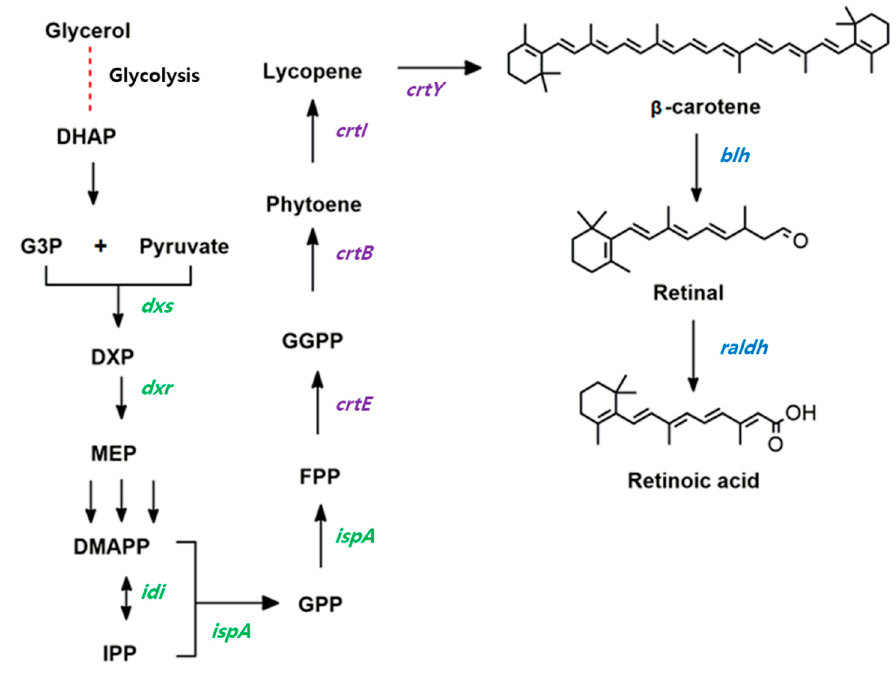
Figure 1. Redesigned biosynthetic pathway of retinoic acid from β -carotene in recombinant Escherichia coli . The genes involved in this redesigned pathway are dxs (encoding1-deoxy- D -xylulose- 5-phosphate synthase); dxr (1-deoxy- D -xylulose-5-phosphate reductoisomerase); idi (isopentenyl diphosphate isomerase); ispA (farnesyl diphosphate synthase); crtE (geranylgeranyl diphosphate synthase); crtB (phytoene synthase); crtI (phytoene desaturase); crtY (lycopene cyclase); blh ( β -carotene 15,15 ′ -oxygenase); and raldh (retinal dehydrogenase).